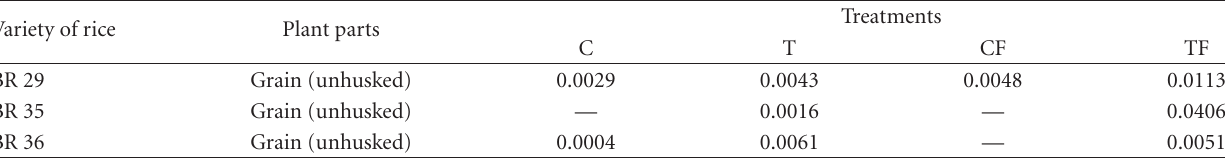
Table 10: Accumulation of As (mg/pot) in boro rice plants.